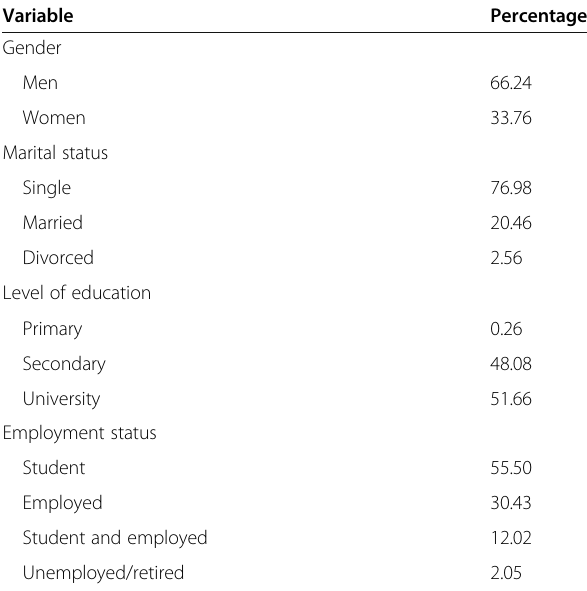
Table 1 Sociodemographic characteristics of the sample ( N